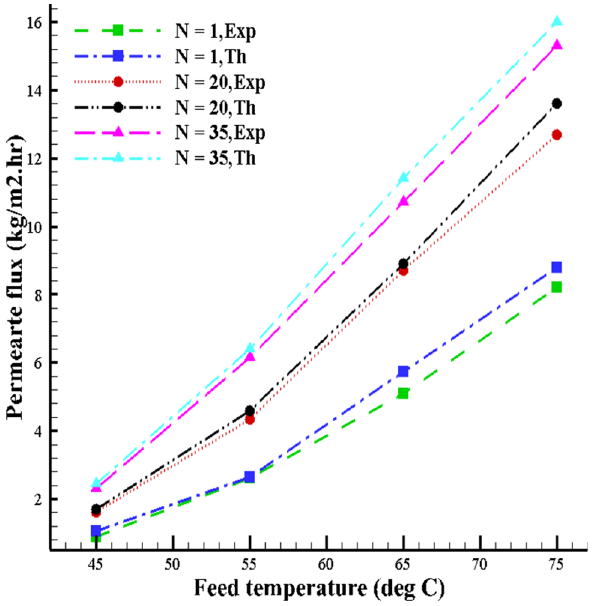
Fig. 6 Validation of theoretical model with experimentation for vari- able feed